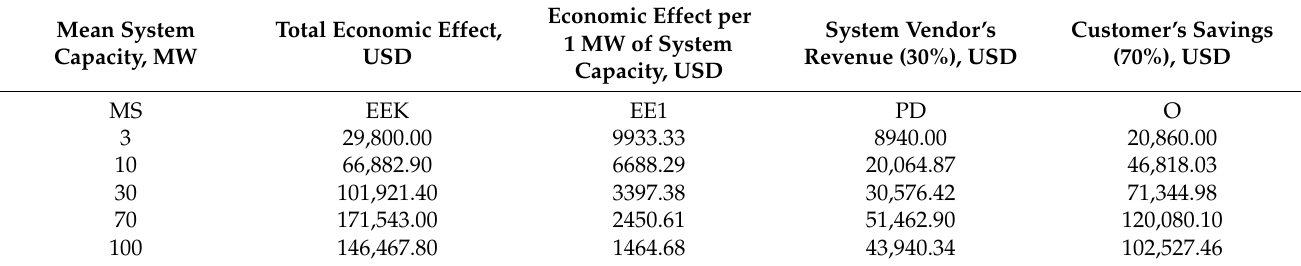
Table 6. The economic effect, as split between the system vendor and the system